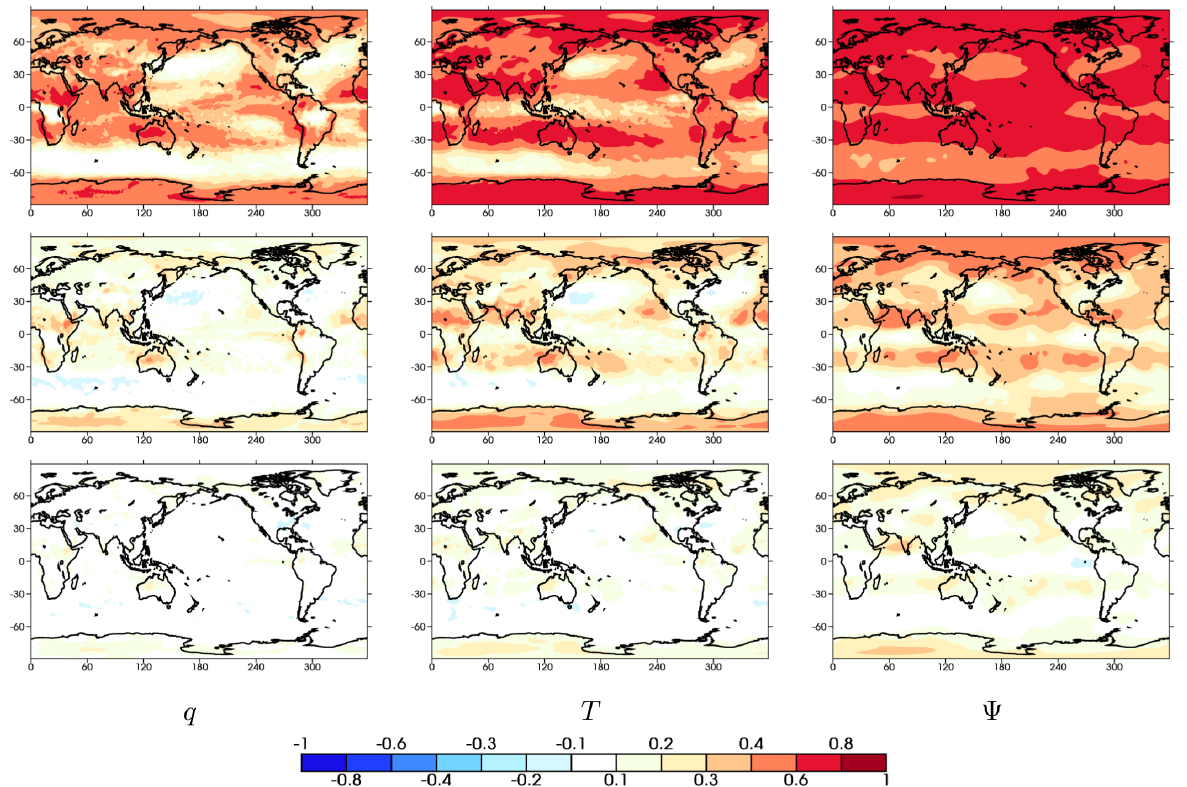
Figure 3. Autocorrelation for lags (top to bottom) 1 to 3 days of February 850hPa humidity (left) and temperature (center) corrections and 500hPa streamfunction corrections